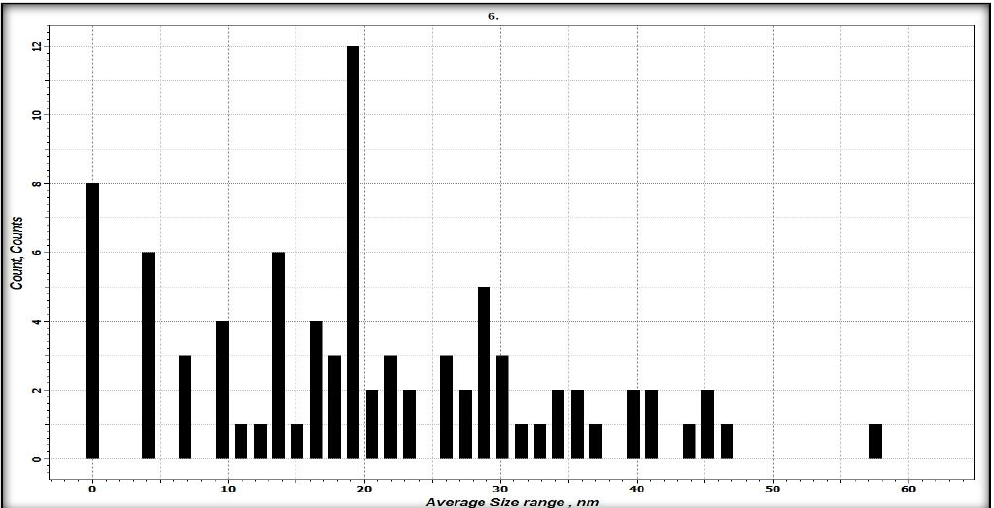
Figure (13): Histogram of particle size distribution of F21 by AFM Conclusion Nano particulate systems have great potentials, being able to convert poorly soluble, poorly absorbed and labile biologically active substance into promising deliverable